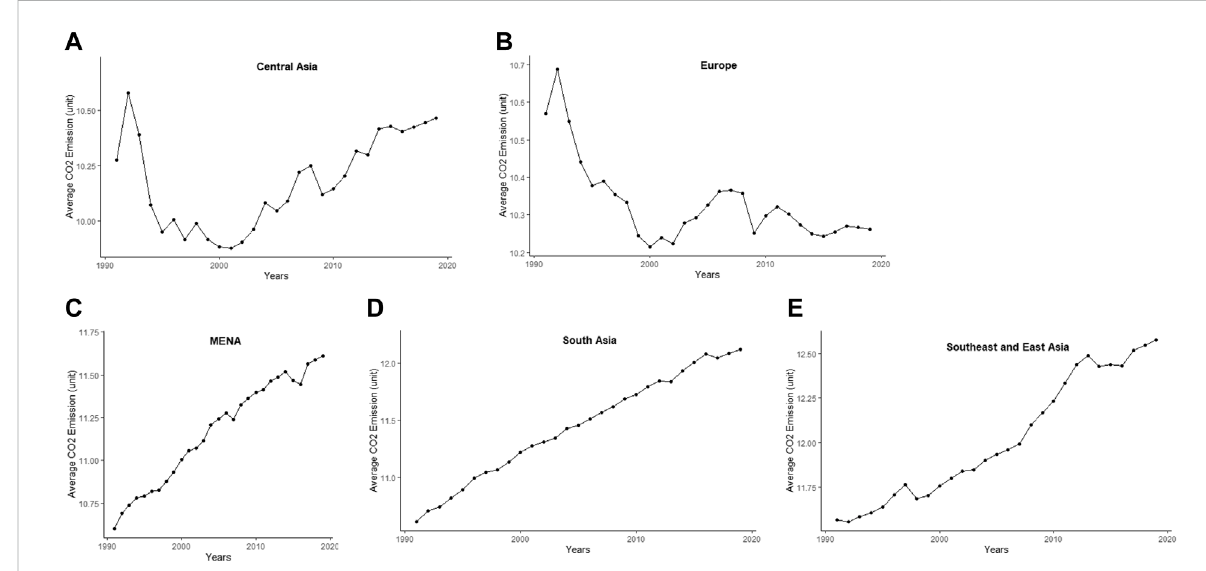
FIGURE 1 Average CO 2 emissions in the (A) central Asia, Europe, (C) MENA, (D) South Asia, and (E) Southeast and East Asia regions. Data Source;